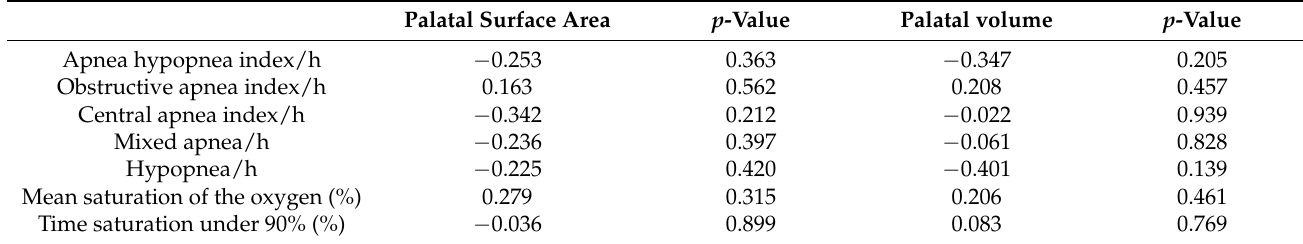
Table 5. Correlation analysis of the Marfan syndrome group between palatal morphology and polygraphic cardiorespiratory monitoring index.